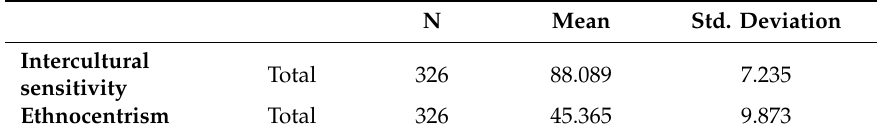
Table 1. Mean and standard deviation of students’ scores in the Intercultural Sensitivity Scale and the Ethnocentrism Scale. N Mean Std.